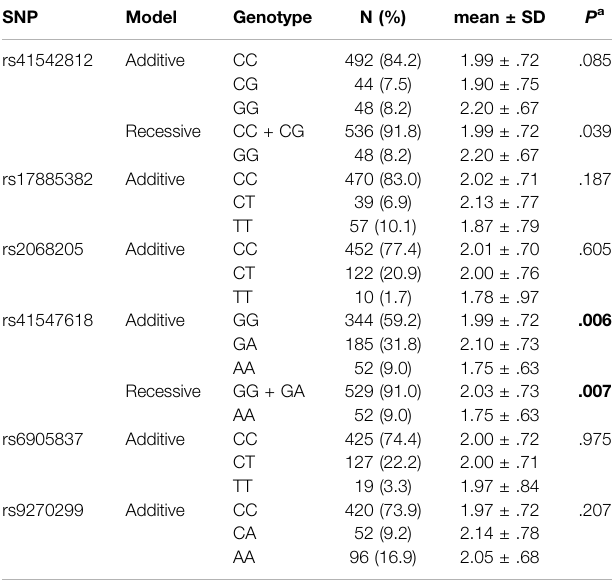
TABLE 3 | Results of covariance analysis for A/H1N1 antibody titers.